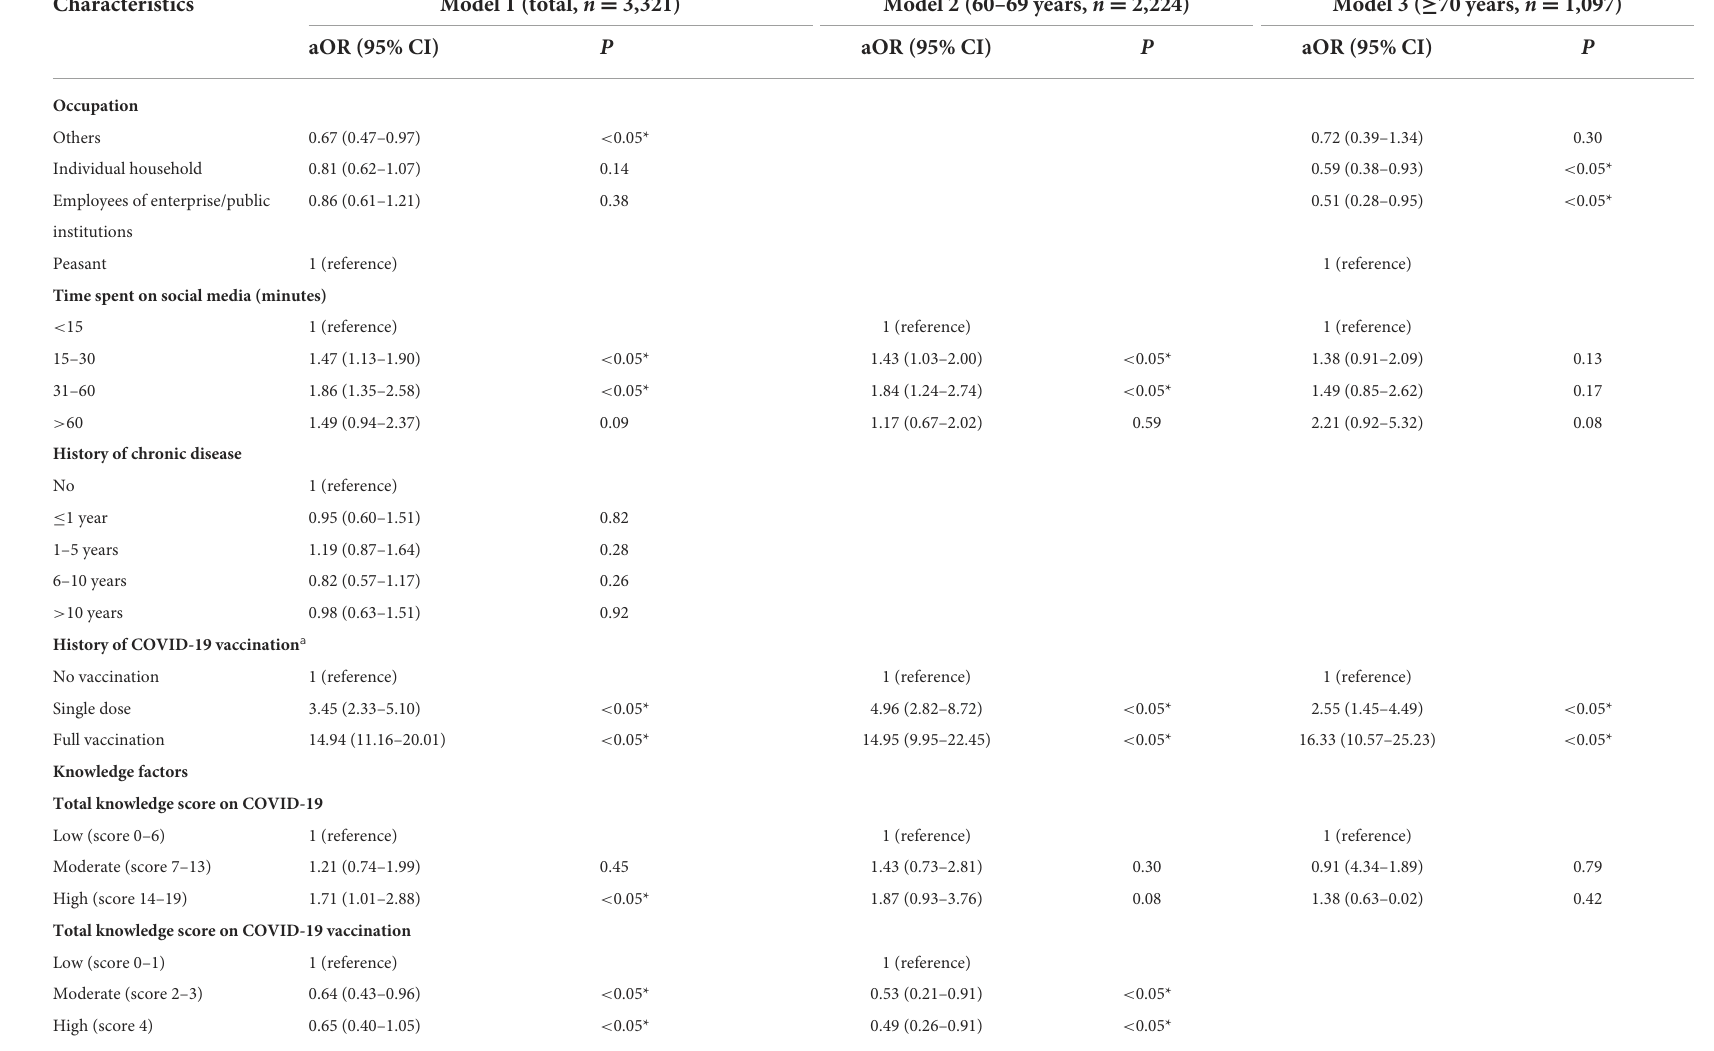
TABLE 3 Multivariable logistic regression of the factors associated with the acceptance of a COVID-19 vaccine booster dose among older people ( n = 3,321).